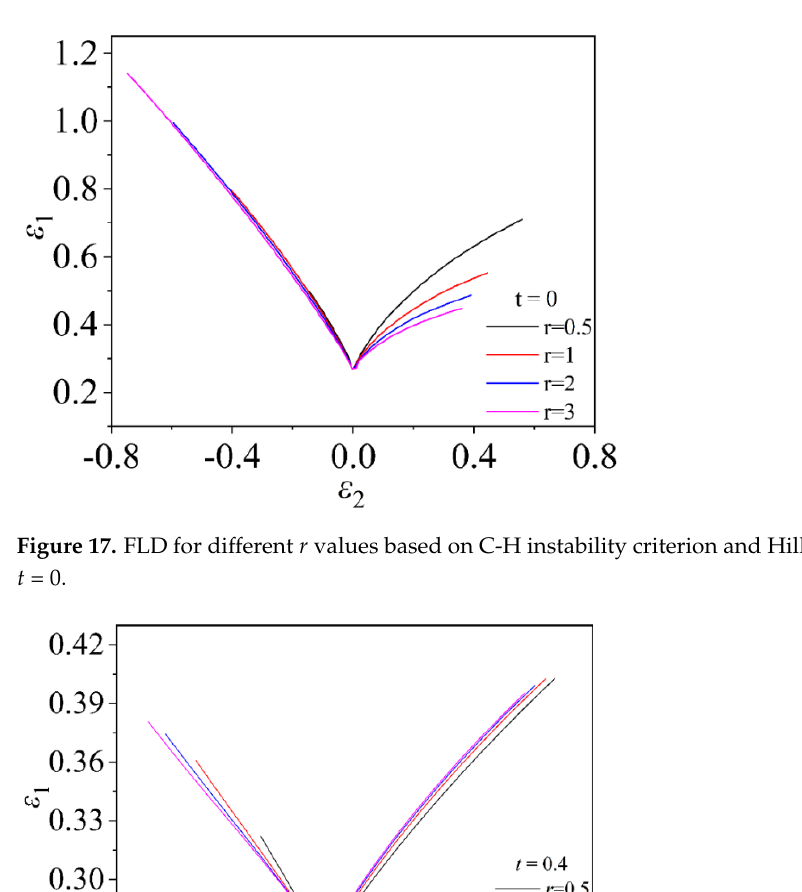
Figure 17. FLD for different r values based on C-H instability criterion and Hill48 yield criterion at t = 0.